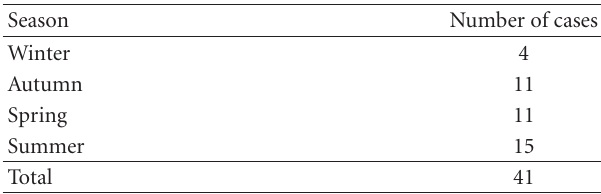
Table 3: Seasonal dispersion pattern of the farm